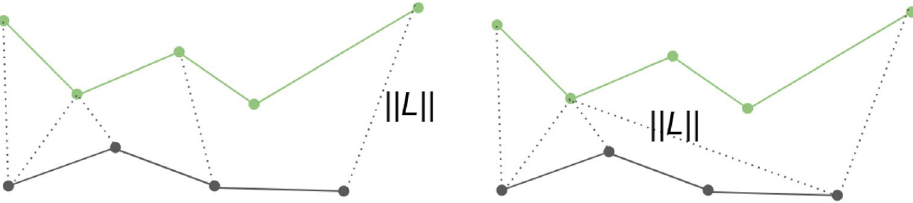
Figure 10. The figure shows two examples of coupling L . Dashed lines represent distinct pairs. (cid:31) L (cid:31) is the length of the longest distance of those pairs. Finally, FD is the minimum of those (cid:31) L (cid:31) .